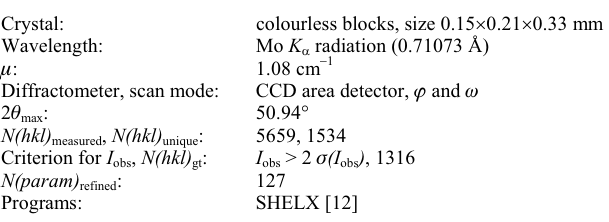
Table 1. Data collection and